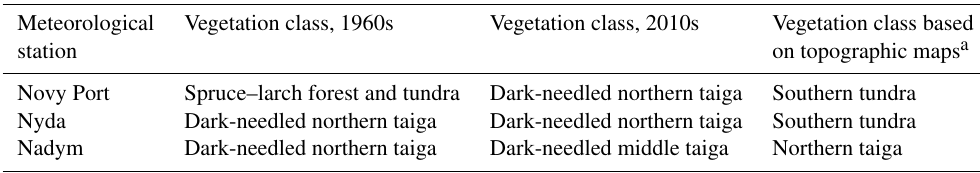
Table 6. Change in vegetation class at meteorological stations in accordance with Table 2 (after Tchebakova et al.,